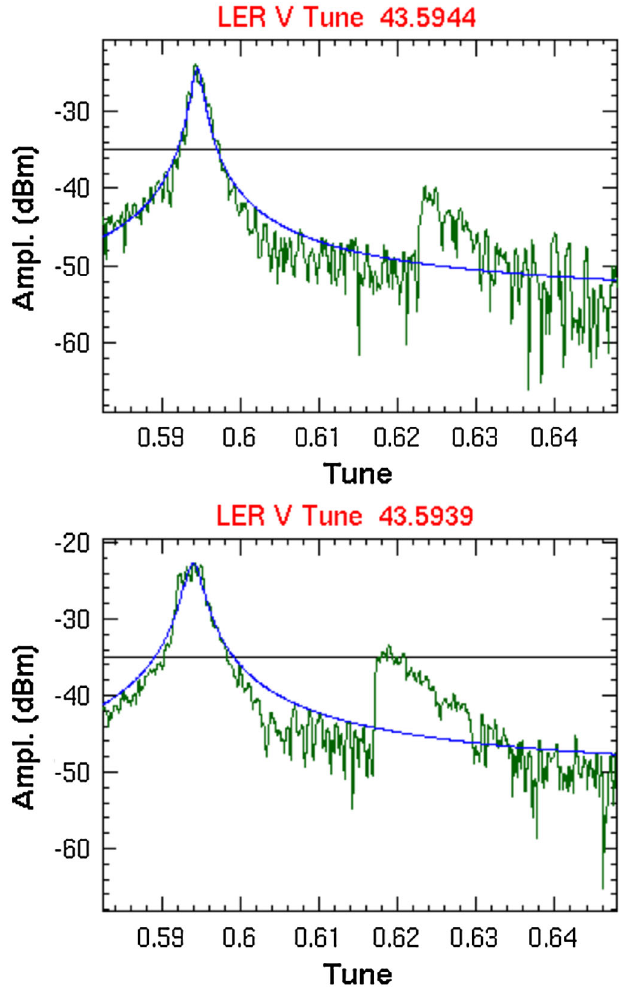
FIG. 4. (Color) Vertical tune spectra of a colliding positron bunch denoted by the green curve. The blue line is a resonance curve fitted to a single peak. The left peak represents the L mode and the right side spectrum represents the H mode. The upper and lower excitation levels are (cid:3) 28 and (cid:3) 25 dB , respectively. In the vertical axis, 0 dBm corresponds to an oscillation amplitude of 0.3 mm. An amplitude of (cid:3) 20 dBm at the detector corre- FIG. 3. Schematic gated tune monitor. sponds to an amplitude of less than 1 (cid:3) m at the